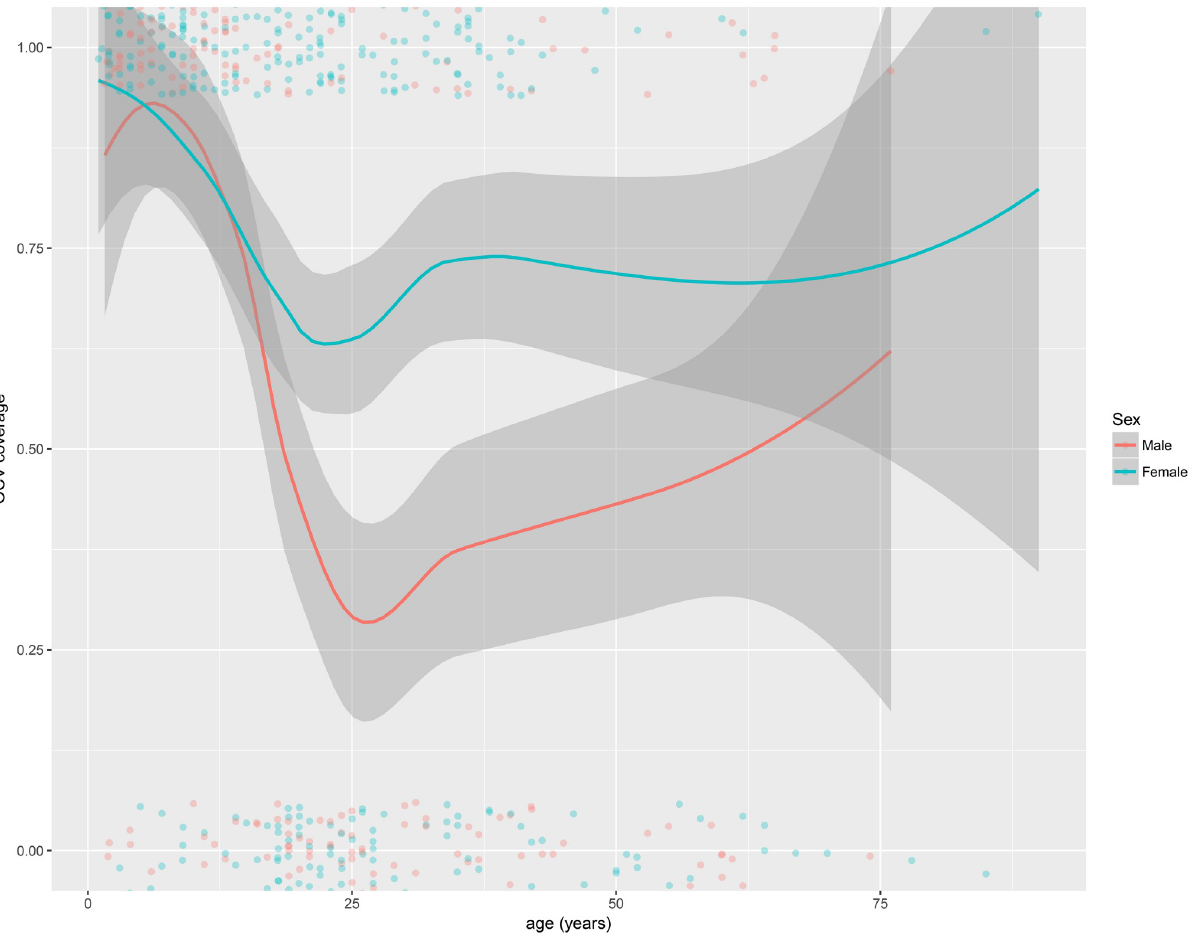
Fig 3. Vaccination coverage with at least one OCV dose by age and sex, Zambia, 2016.